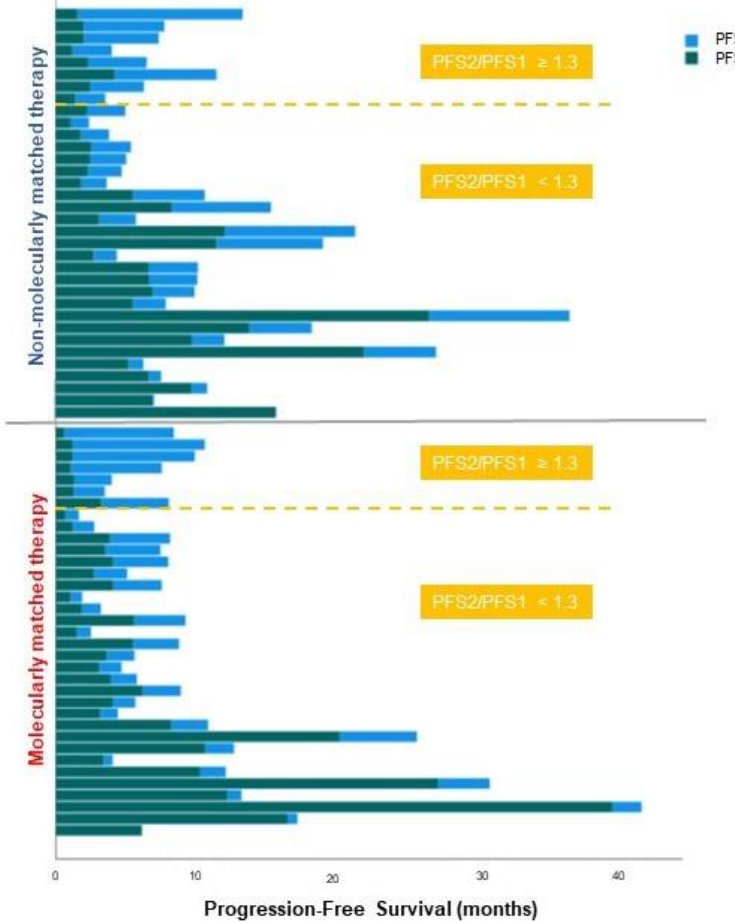
Figure 5. Duration of PFS1 and PFS2 according to the treatment regimen, ordered by decreasing PFS2/PFS1 ratio. Patients above the yellow line have a PFS2/PFS1 ratio ≥ 1.3. Table 3. Efficacy parameters.